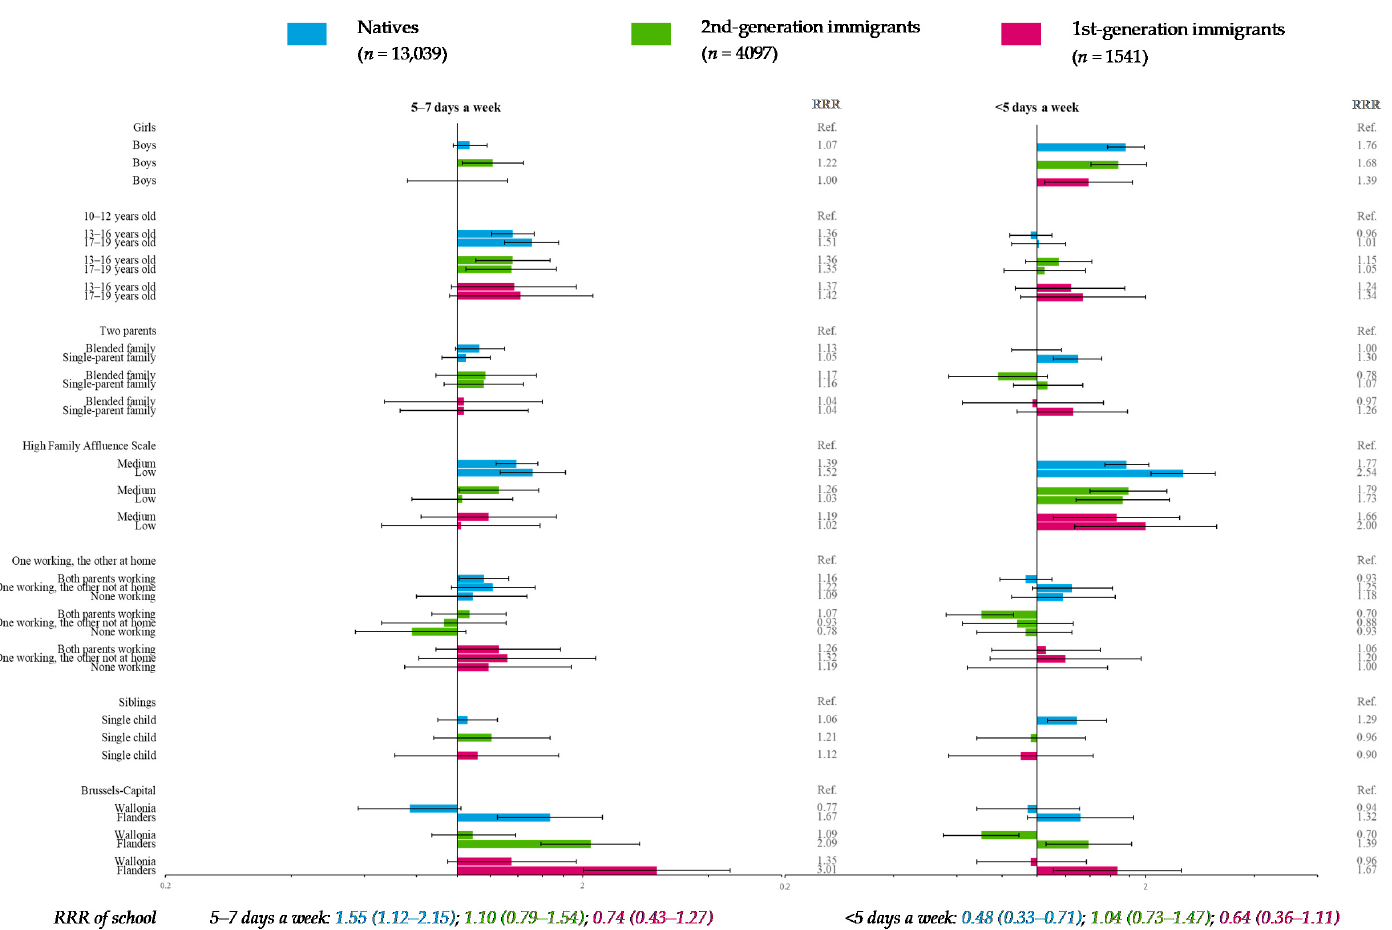
Figure 4. Multiple multilevel multinomial regression* for vegetable consumption (reference category: >once a day) stratified by migration status—HBSC, Belgium, 2014 ( n = 18,974). * RRR < 1: More favorable for health; RRR > 1: Less favorable for health.